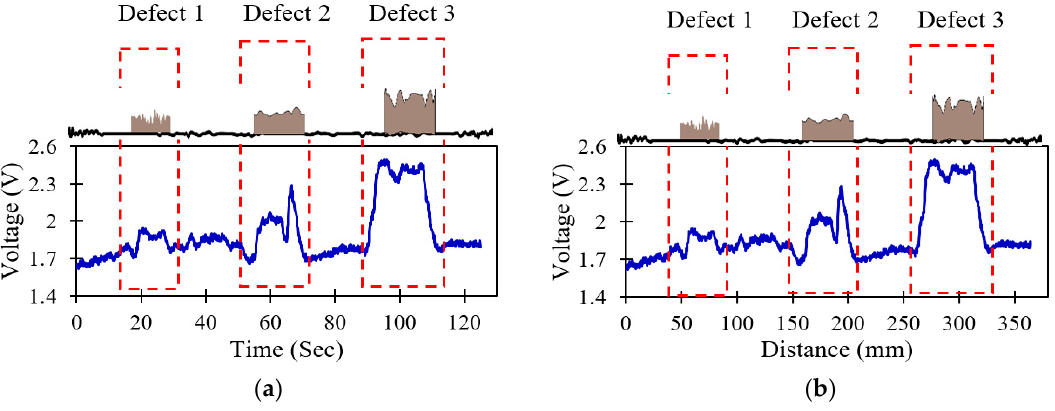
Figure 6. The records acquired sensor signals in the presence of deposit corrosion for 20-mm lift-off and 2.9 mm/s; ( a ) original time-domain sensor signal, ( b ) corresponding distance sensor signal.